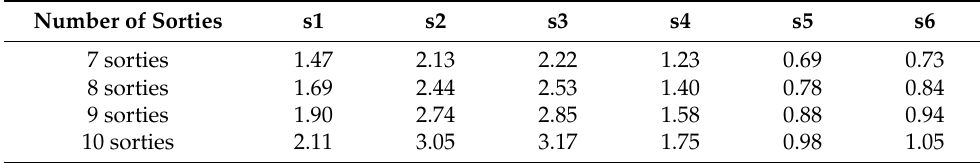
Table 8. Additional sorties gained in the solutions.